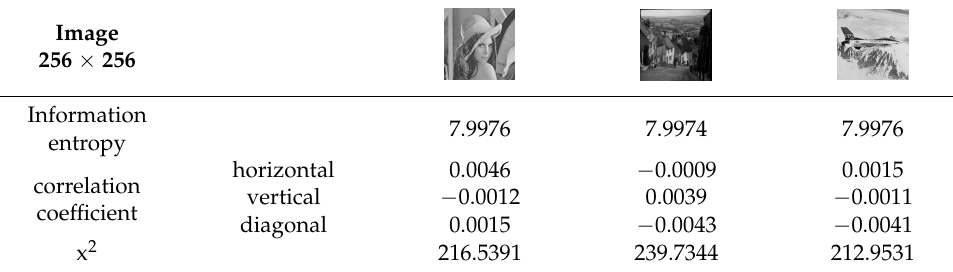
Figure 17. Histogram of each component before and after images of 256 × 256: ( a – c ) Histogram of images of 256 × 256; ( d – f ) Histogram of encrypted images of 256 × 256. Table 9. Security and performance analysis of color image.